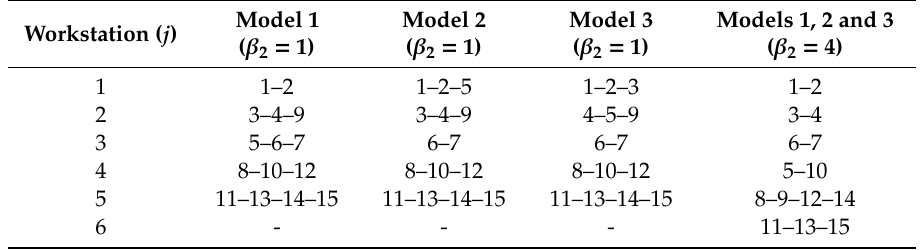
Table 11. Optimal assignment of tasks to workstations to the instance from [11]. Figures represent tasks ( i